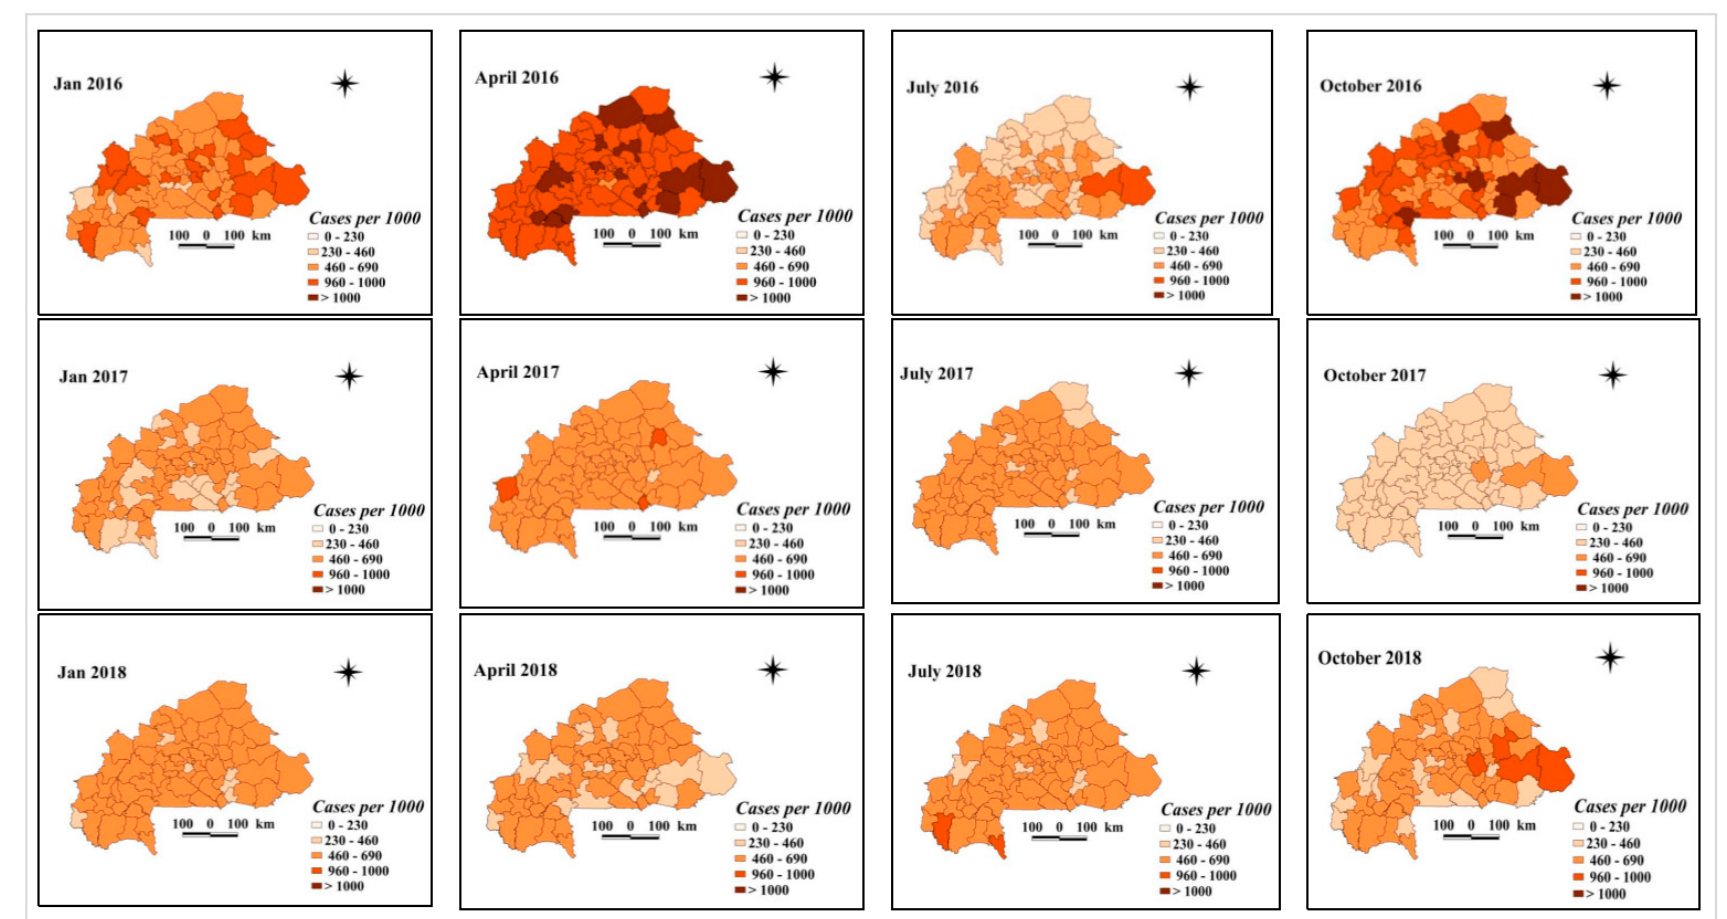
Figure 4. Space–time patterns of confirmed malaria incidence (cases per 1000 children) in children less than 5 years estimated from the Bayesian spatio-temporal model.